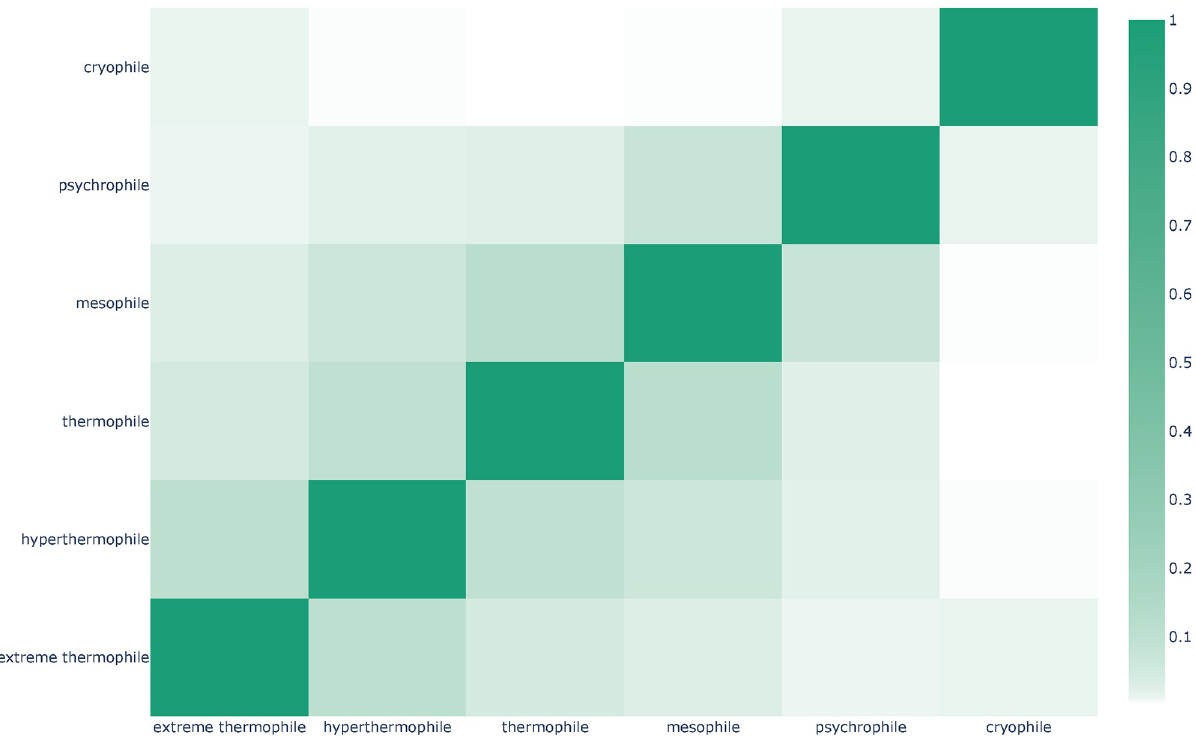
Fig 9. Correlation between temperature tropism phenotypes in Omnicrobe. Each box represents the intersection between the sets of taxa to which the two phenotypes are linked with Exhibits relations in Omnicrobe. The color intensity indicates the Jaccard index between the sets of taxa.